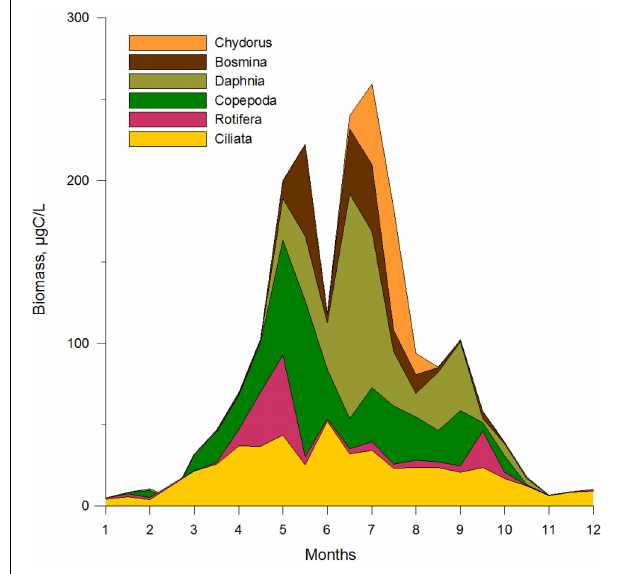
FIGURE 5 | Seasonal dynamics of zooplankton biomass in the Curonian